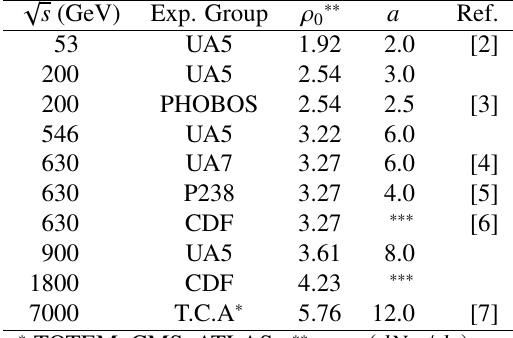
Table 1. Pseudo-rapidity density at η = 0 and value of the parameter a .